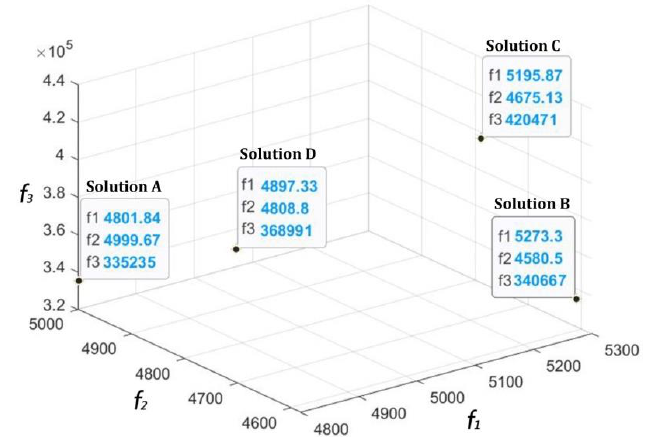
Figure 3. Pareto optimal solutions.